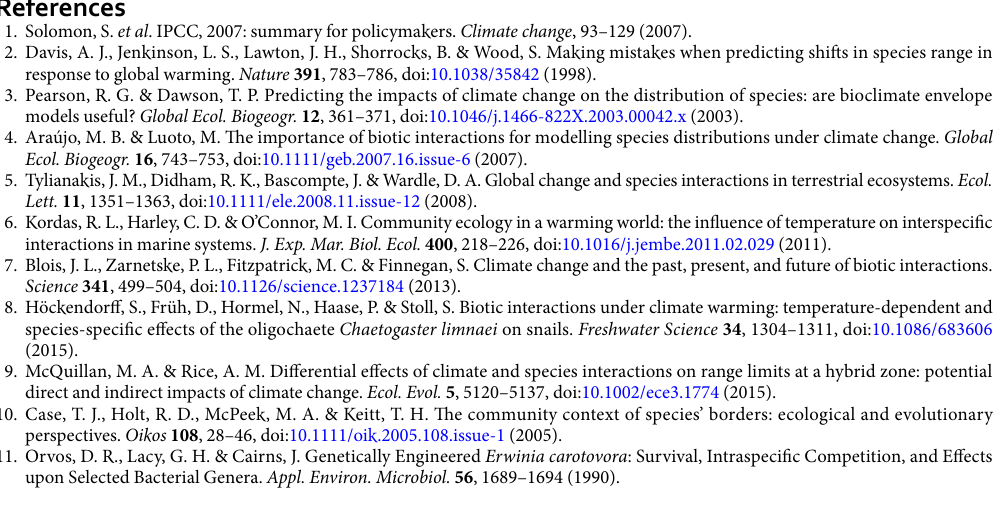
DNA sequences used to develop the primers: NCBI Reference Sequence: LN624115, LN624122. Melting temperatures and calibration curve for HRM runs in supplementary material: Fig. S3.